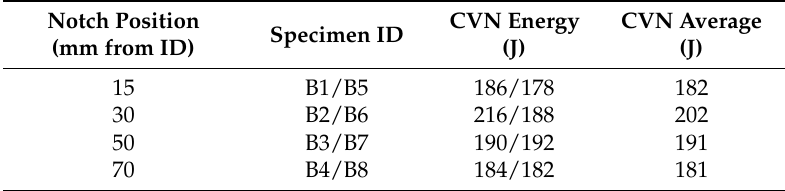
Table 3. Results from CVN-B impact test configuration.